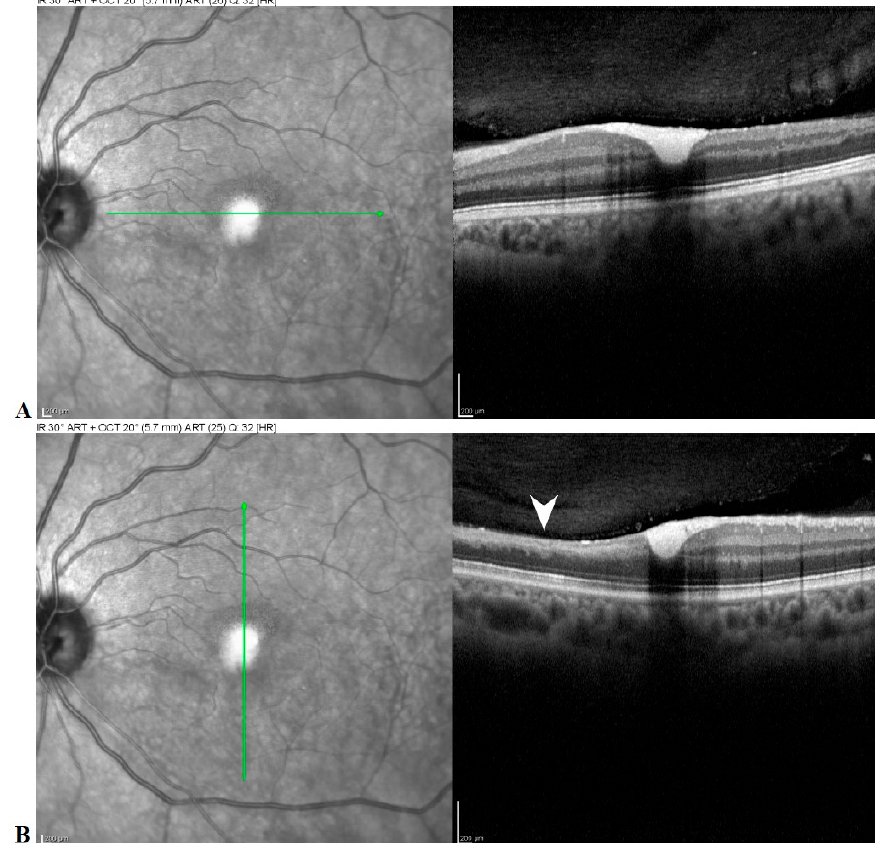
Figure 5. Horizontal ( A ) and vertical ( B ) spectral domain OCT B-scans show hyperreflective material deep to the attachment between the posterior hyaloid and the internal limiting membrane (ILM) and filling the foveal depression suggestive of residual hemorrhage. Note the thinning of the inner retinal layers inferiorly from recent branch retinal artery occlusion (arrowhead). At 11-week follow-up, visual acuity in the left eye had returned to 20/20. Funduscopic exam was significant for complete resorption of blood and a residual wrinkly yellow sheen over the central macula. Humphrey visual fields remained stable. SD-OCT revealed a bridging membrane over the foveal depression. OCT-A (AngioVue; Optovue Inc. Fremont, CA, USA) was limited by artifact but suggested decreased retinal vascular bed density in the inferior macula (Figure 6).